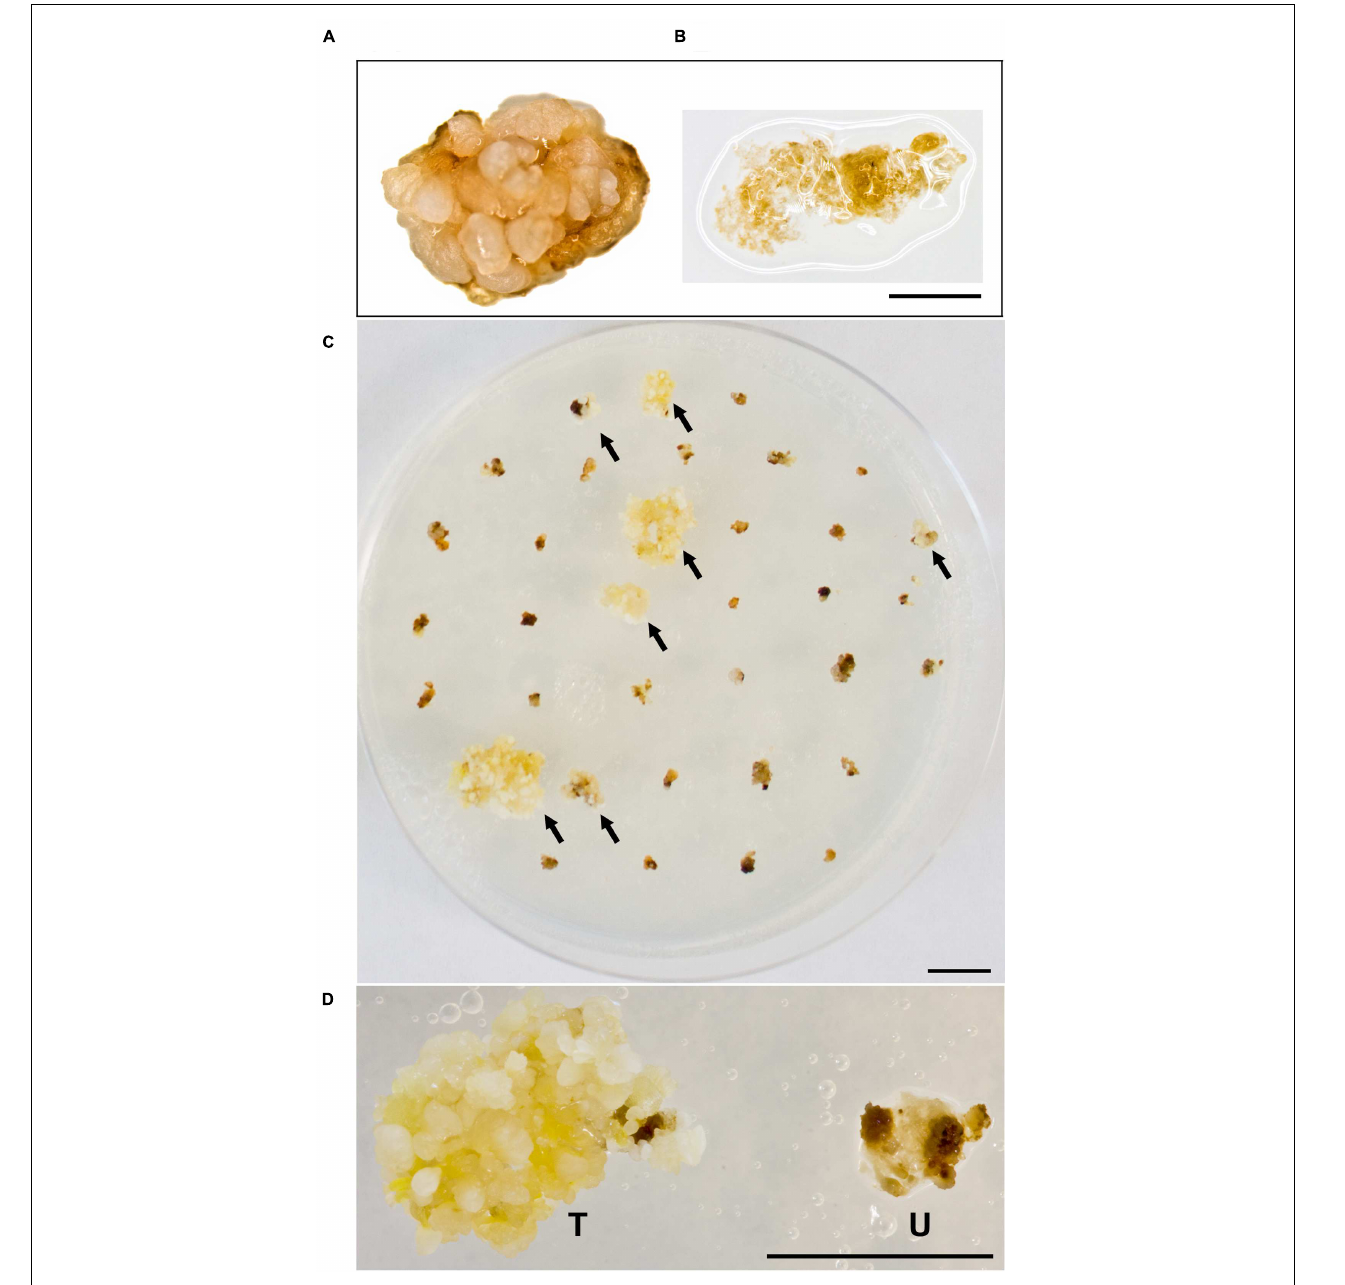
FIGURE 3 | Selection of B. sylvaticum callus on paromomycin media. WT B. sylvaticum callus can tolerate paromomycin at 250 mg L − 1 and grows (A) but at 750 mg L − 1 (B) the tissue disintegrates with a watery appearance and dies; Scale bar = 1 mm. (C) B . sylvaticum tissue after 4 weeks under paromomycin selection at 500 mg L − 1 ; arrows indicate transformed, paromomycin resistant calli; scale bar = 1 cm. (D) Magnified view of B . sylvaticum callus at 4 weeks under paromomycin selection; transformed callus (T) has a yellow-white appearance relative to untransformed callus (U) which is brown and dying; scale bar = 1